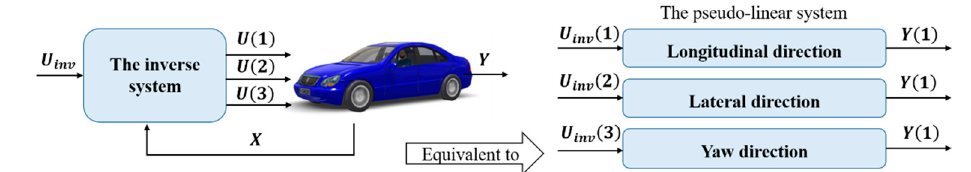
Figure 2. The decoupling principle of the inverse system.